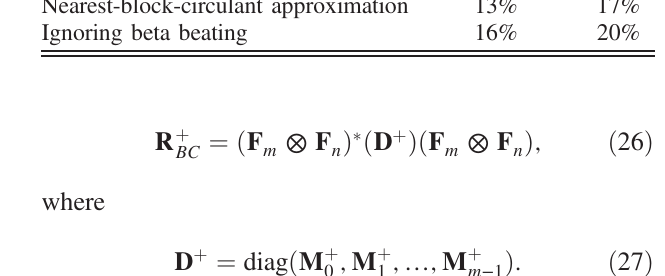
FIG. 7. Tune modes of a DFT matrix ( F (cid:4) 6 ⊗ F (cid:4) 14 Þ [blue (solid) line] and SVD matrix U [red (dotted) line] for the SIS100 ORM in the x plane. The horizontal tune is 18.87.